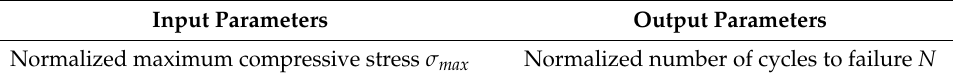
Table 3. Input and output parameters.